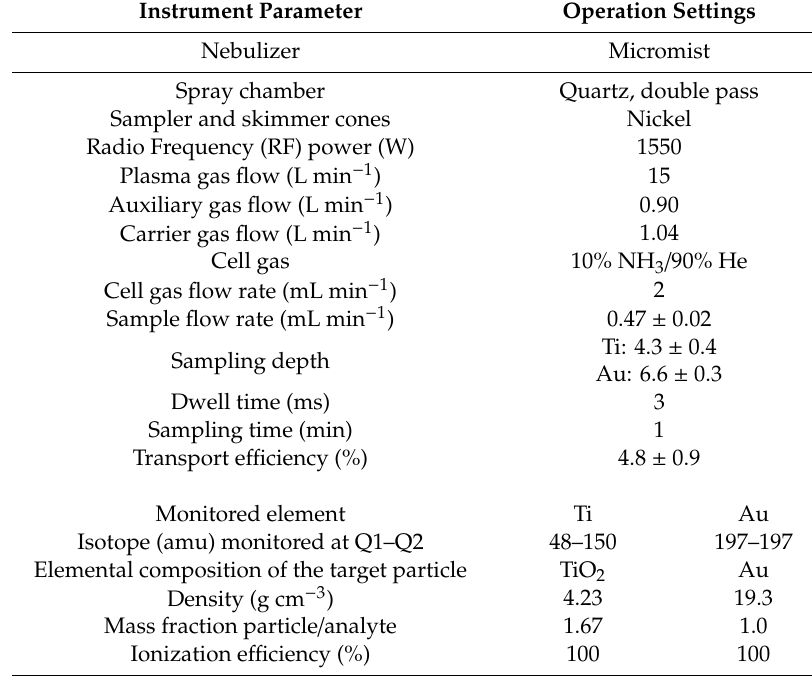
Table 3. Applied settings for single particle inductively coupled plasma mass spectrometry (spICP-MS) measurements with inductively coupled plasma mass spectrometry (ICP-MS) /